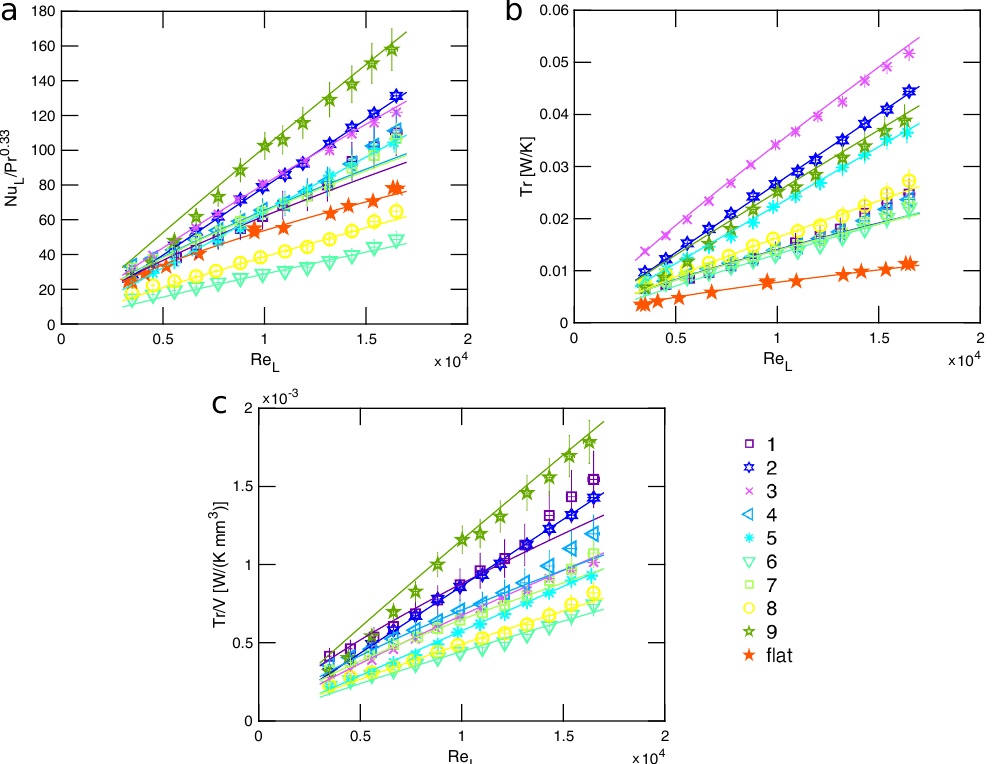
Figure 7. Experimental performance of heat sinks with cones surface patterns at different Reynolds number: ( a ) Ratio between Nusselt and Prandtl numbers, Nu L / Pr 0.33 ; ( b ) thermal transmittance, Tr ; and ( c ) ratio between thermal transmittance and sample volume, Tr / V . In the legend, the number of each sample is associated with a symbol and color and “flat” stands for the reference heat sink with smooth surface. Symbols represent experimental data, and lines are model predictions (Equations